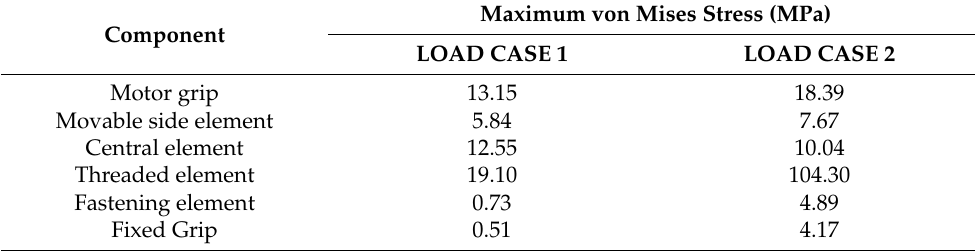
Table 2. Maximum values of von Mises stress on the components.